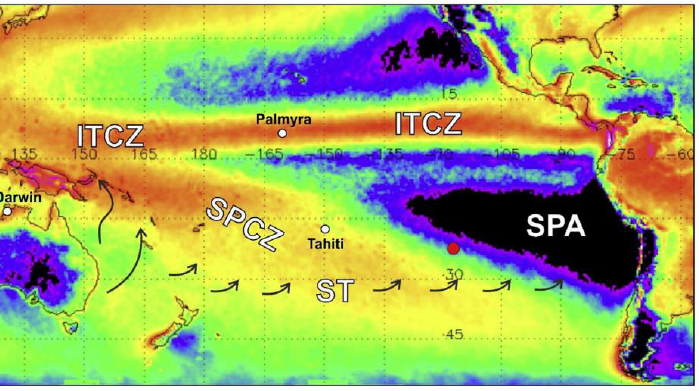
Figure 1. Main climate systems of the South Pacific: ITCZ, Intertropical Convergence Zone; SPCZ, South Pacific Convergence Zone; SPA, South Pacific Anticyclone; ST, Storm Tracks. Colors indicate precipitation gradients from <100 (black) to >1200 (red) mm per year, 1987 – 2003. Rapa Nui (Easter Island) is represented by a red dot [17].